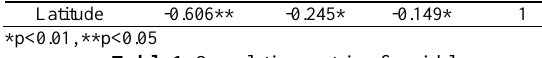
Table 1. Correlation matrix of variables.